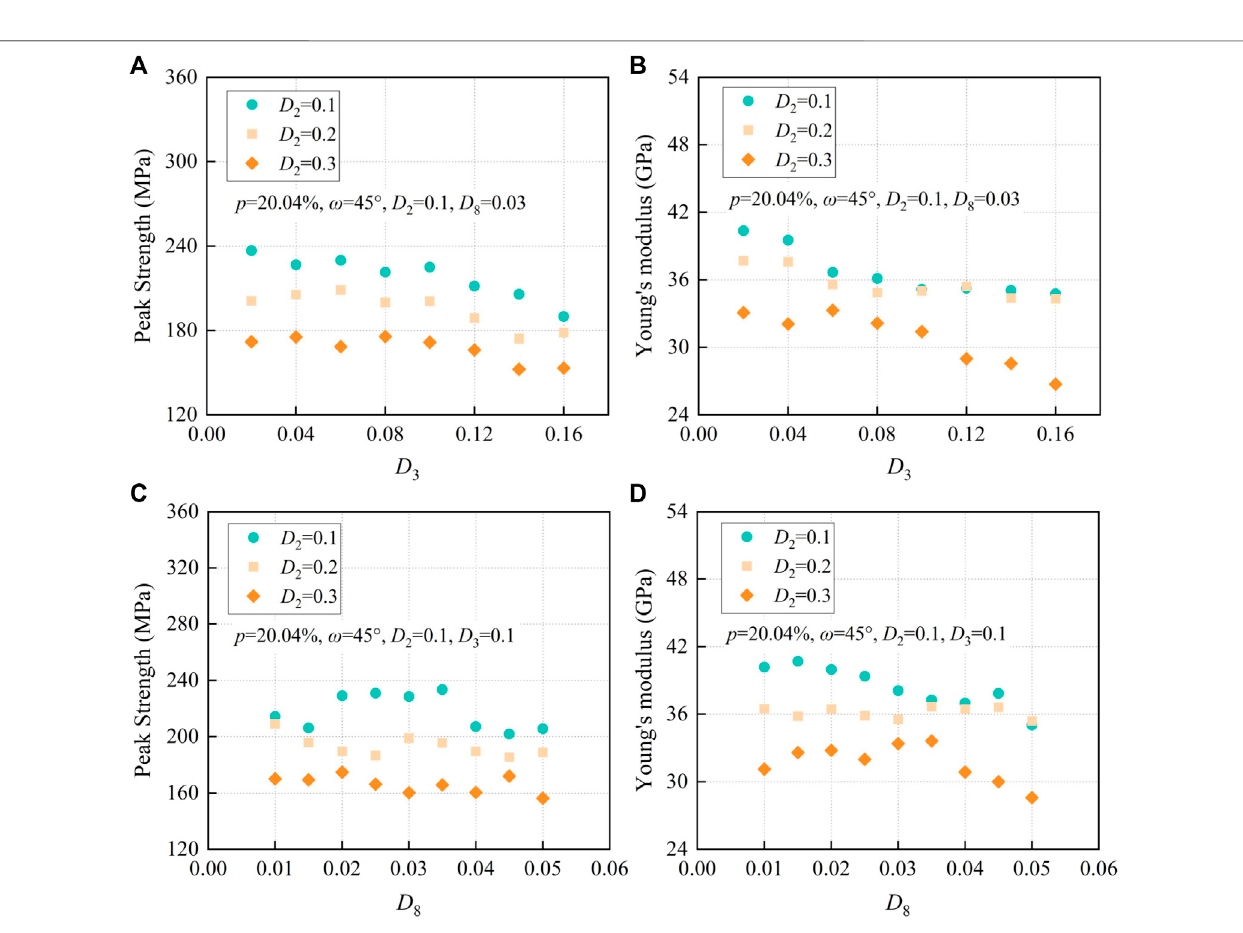
Frontiers in Materials |